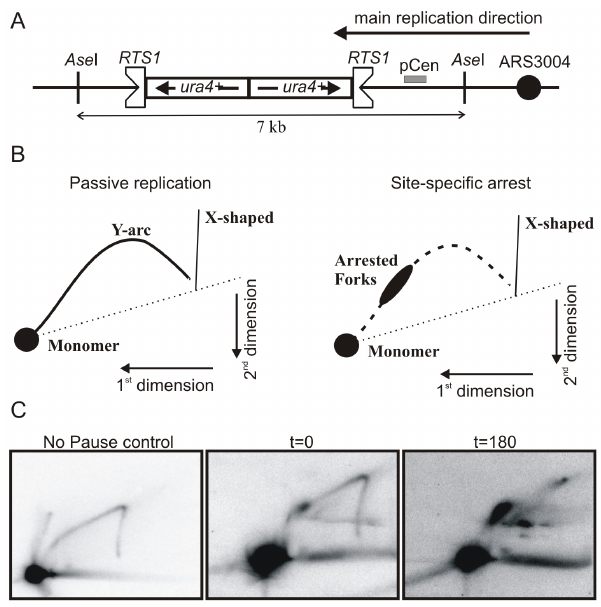
Figure 4. Use of the S.pombespo5 gene DSR element allows for tighter regulation of Rtf1 expression in an RTS1-dependent replication fork stall system. (A) Schematic illustration of inverted ura4 repeat double RTS1 ( RuiuR ) construct. RTS1 is a polar replication fork barrier. The triangular indent indicates the surface that prevents fork progression. (B) Cartoon representation of the expected replication intermediates (RIs) at the RuiuR locus as analysed by two-dimensional gel electrophoresis (2DGE). Left panel: RIs expected when the Ase I fragment indicated is replicated passively (no fork arrest at the RTS1 barrier). Right panel - RIs expected in RuiuR cells upon fork arrest. (C) Left panel: control cells with no pause, demonstrating the position of the Y-arc. Middle and right panels: The rtf1 ORF was inserted at the urg1 locus in rtf1 D cells by Cre-mediated cassette exchange to create YSM098 (see Table 1). The strain was grown in EMM + LA at 30 u C (asynchronous culture) and Rtf1 protein induced by the addition of uracil at 0.25 mg/ml. Samples taken at time-points shown. Chromo- somal DNA was digested by A se I, and RIs were analysed by 2DGE.